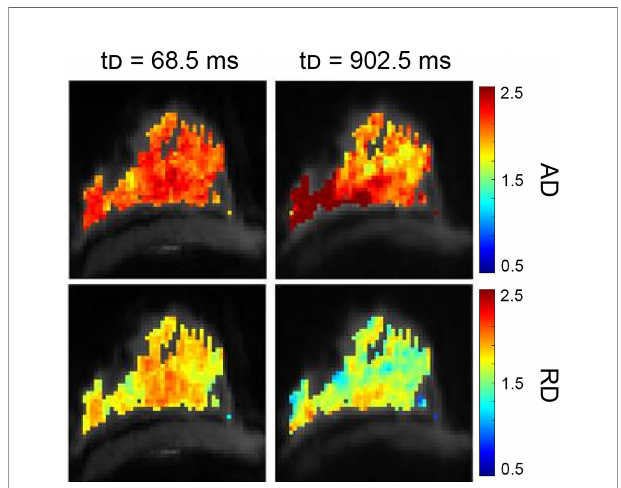
FIGURE 10 | Example of STEAM analysis in a healthy volunteer. The protocol collected a prototype STEAM-DTI sequence with two b-values (0, 500 s/mm 2 ) in six directions with parallel imaging in a 3T scanner. Axial diffusivity (AD, fi rst row) and radial diffusivity (RD, second row) [µm 2 /ms] parametric maps at the shortest and longest diffusion time for healthy fi broglandular tissue are shown (212). (Courtesy of Jose Teruel,